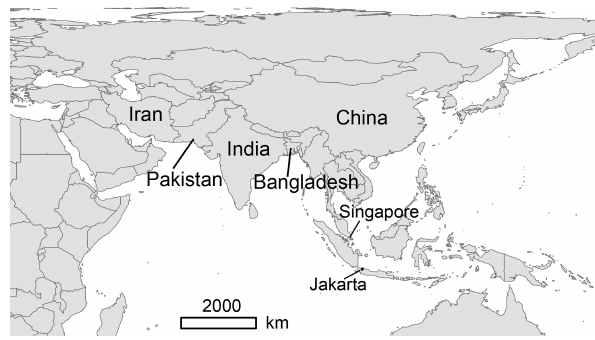
Figure 1. Map showing the Asian countries and cities mentioned in the